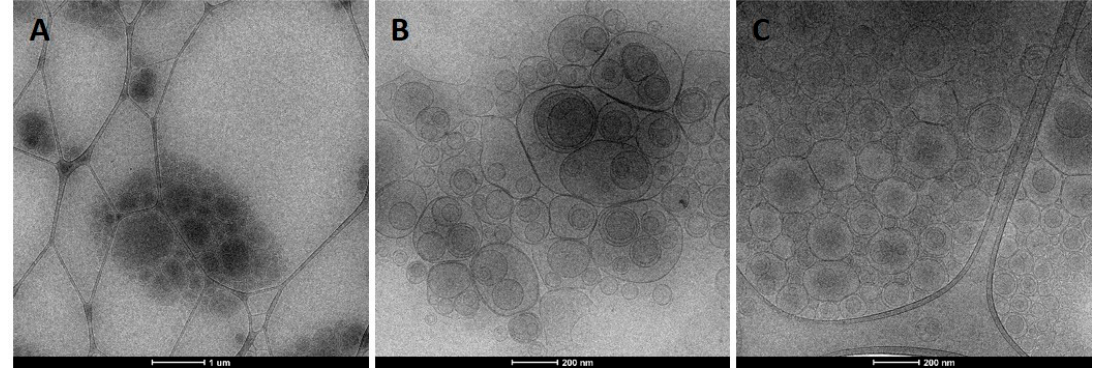
Figure 2. Cryo-TEM micrographs of L. citriodora extract loaded in liposomes ( A ), glycerosomes ( B ) and propylene glycol-containing vesicles (PG-PEVs; C ).